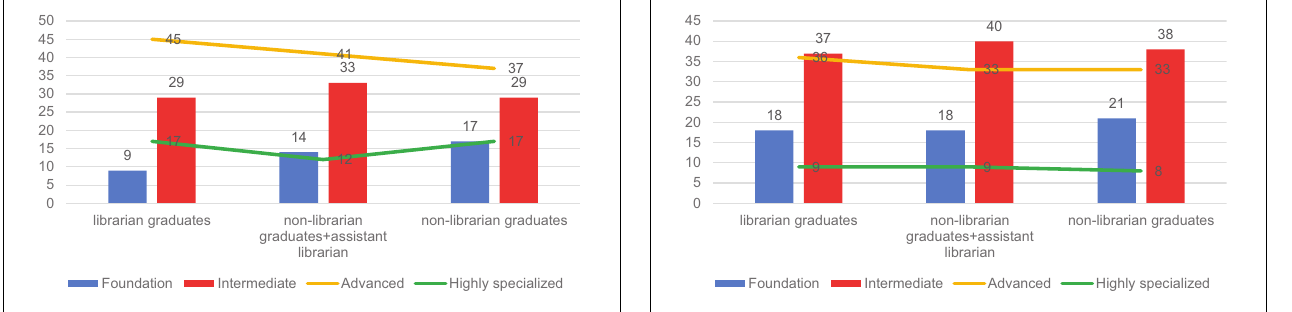
FIGURE 4 | Information and data literacy. Diplomas and qualifications. FIGURE 5 | Communication and collaboration. Diplomas and